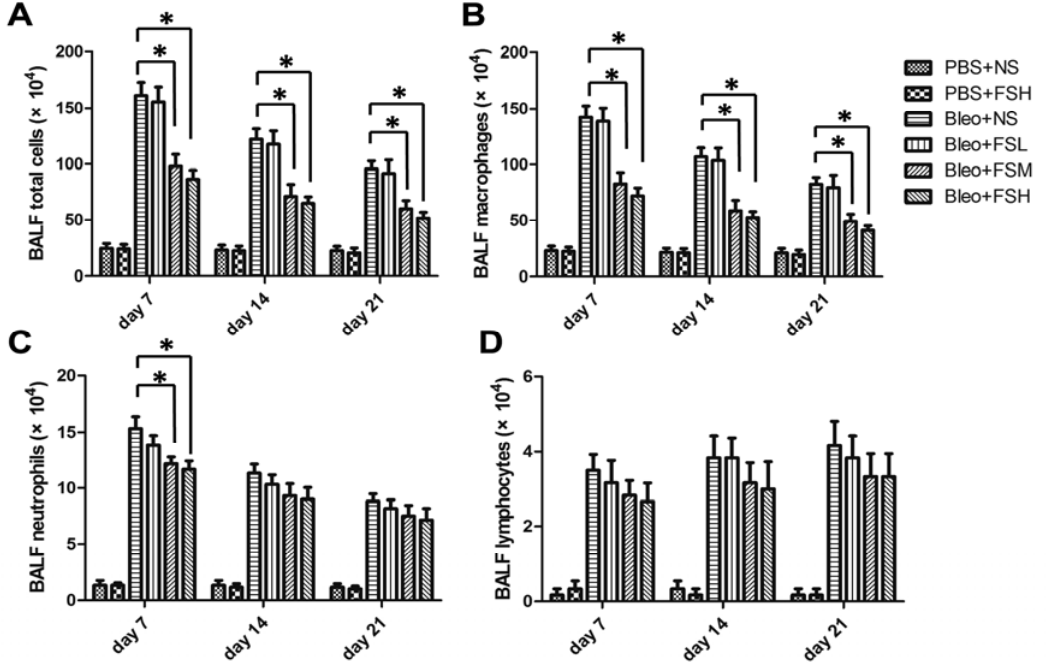
Figure 3. Infiltration of inflammatory cells in BALF collected on days 7, 14 and 21 after bleomycin administration. ( C ) neutrophil numbers; and ( D ) lymphocyte numbers, respectively. Results are expressed as means ± SEM ( n = 6). Statistical analysis was performed using one-way ANOVA followed by Tukey’s multiple comparison test (* p <